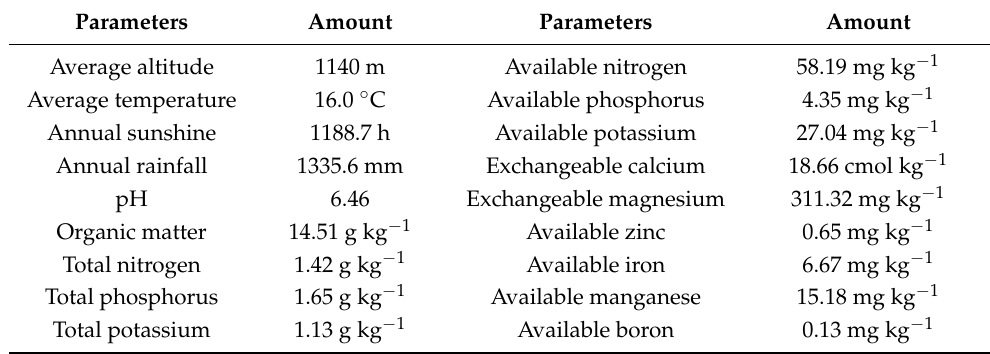
Table 3. The basic information of the P. ternata herb